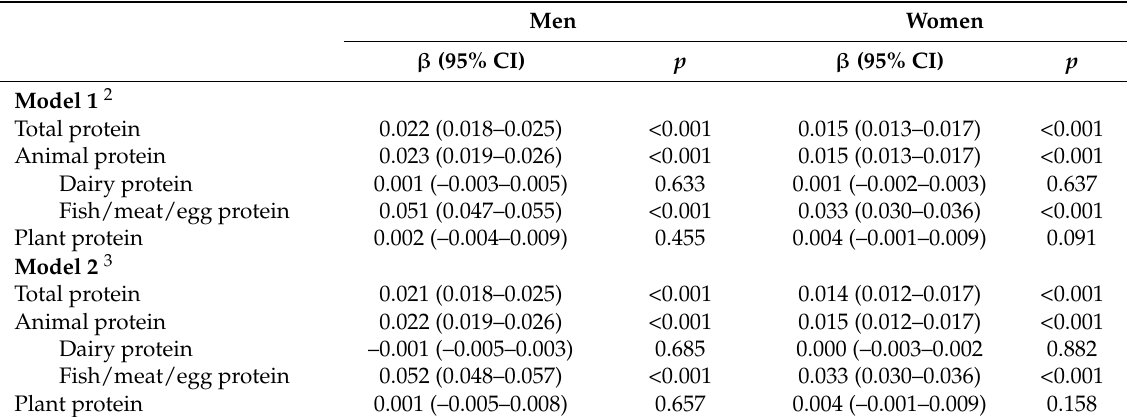
Table 3. Adjusted regression coefficients (and 95% CI) for creatinine excretion (mmoL/24 h) per unit of energy-adjusted protein intake 1